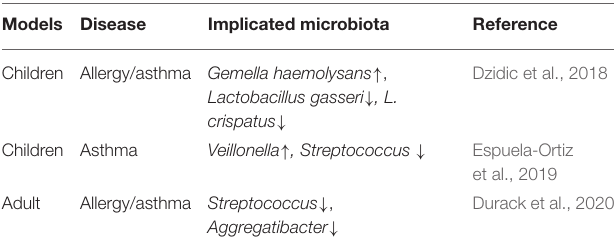
TABLE 1 | Changes in oral microbiota composition associated with allergy/asthma. Models